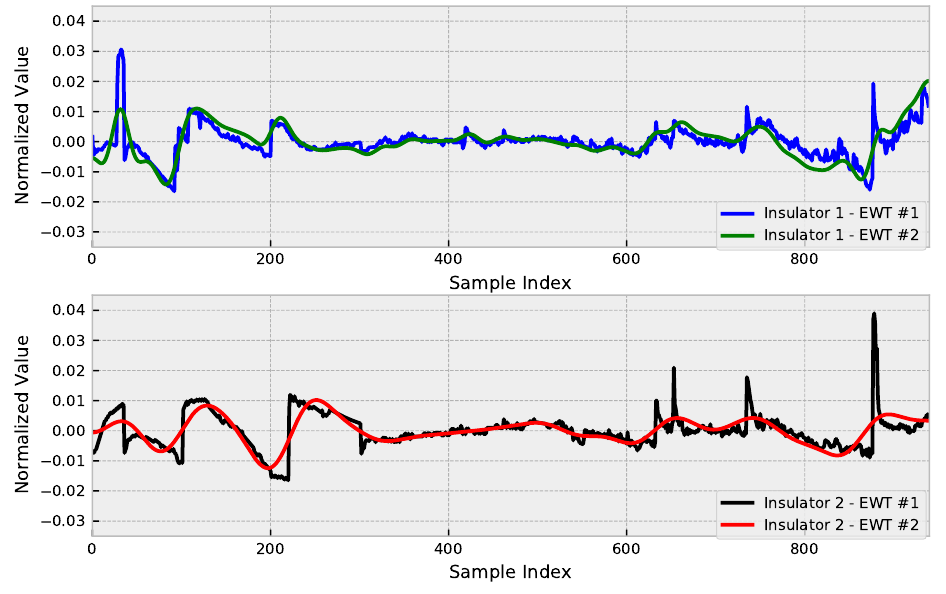
Figure 4. EWT detrend results.